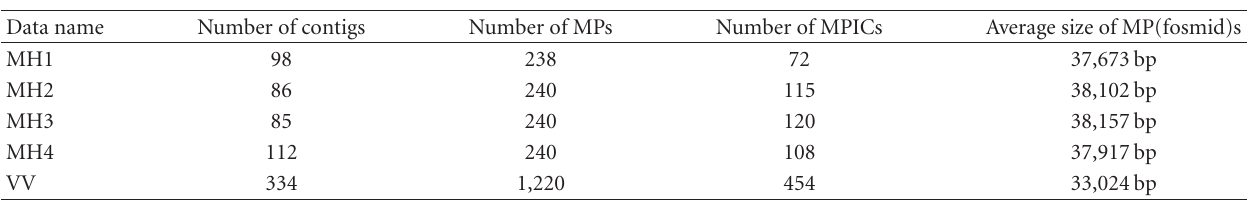
Table 2: Real test datasets. Four datasets for the M. succiniciproducens genome and one for the V. vulnificus genome were tested with ConPath . MP: mate-pair, MPIC: mate-pair in the same contigs.